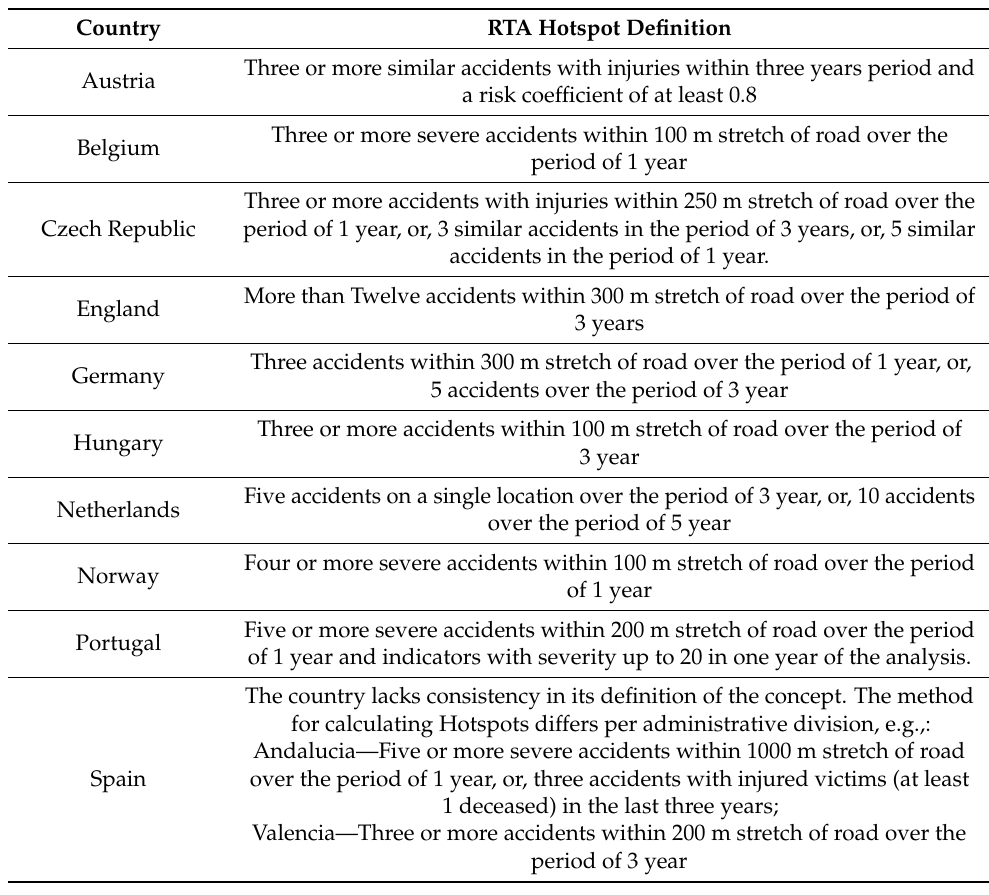
Table 1. Summary of Hotspot definitions found in